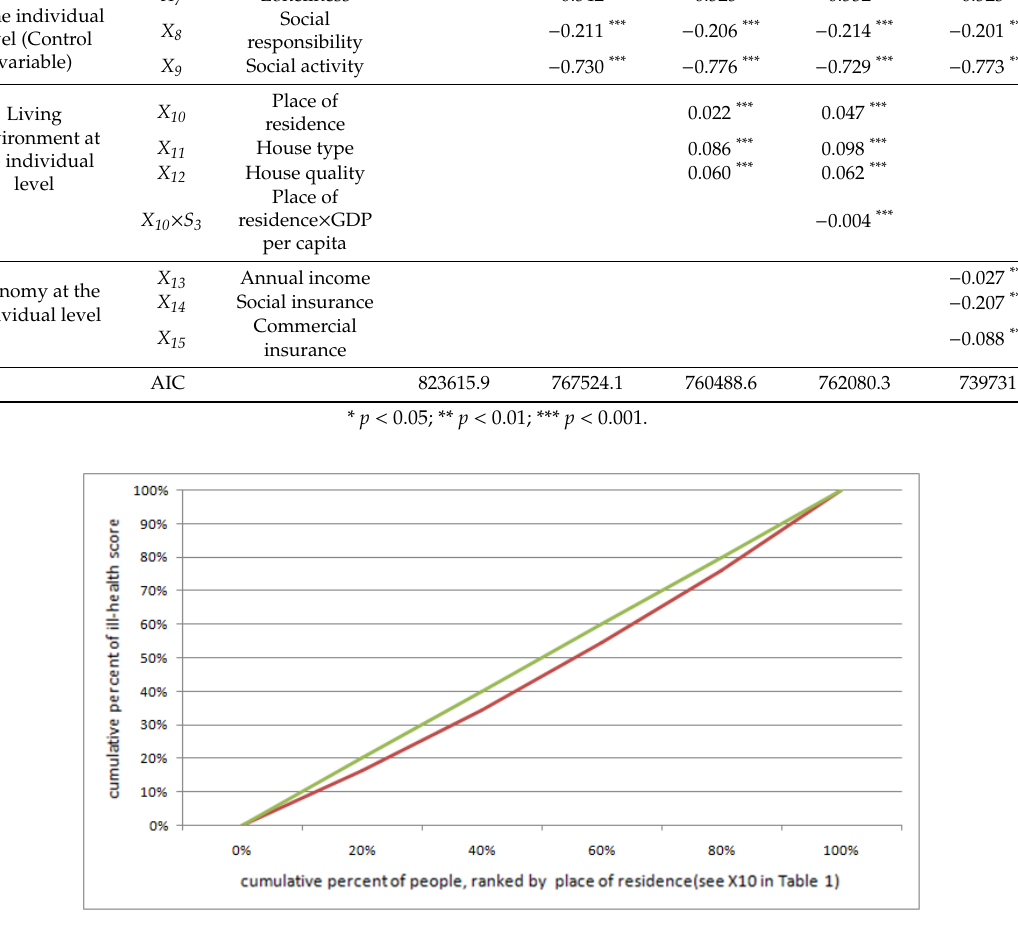
(b) Figure 5. Ill-health concentration curve (red curve) of elderly health by SES difference at the individual level in China. ( a ) Urban vs. rural-related elderly health inequality, CI = 0.3544; ( b ) income-related elderly health inequality, CI = − 0.1428. 4. Discussion 4.1.A Significant Geographical Differentiation in Elderly Health in China According to the 4th SSEP, the overall elderly health status in China shows a “high in coastal, poor in central” spatial pattern [26,46,49] with the higher health provinces being Tianjin, Jiangsu, Shanghai, Zhejiang, Fujian and Beijing. Combined with the studies discussed in Section 3.2 that analyze the determinants of health differences, we confirm that these six most affluent provinces have the best economic, medical and educational conditions. Based on the analysis of Local Moran’s I cluster, Figure 3 shows that the high-health group formed a health hot-spot region in the Yangtze River Delta. Comparing our results with the conclusions of Du (2013) on the health inequalities of the elderly before 2008 [37], we find that the higher health hot-spot region was shrinking, and Jilin, Liaoning, Beijing, Tianjin, Hebei, Shanxi, Shandong, Henan, Hubei and Anhui provinces no longer belonged to the health hot-spot region. This indicates that inter-provincial health equality is increasing from a geographical perspective. In contrast, Inner Mongolia and Gansu, which are places in which the SES in China is the worst, make up a poor health hot-spot region, indicating that this area and its neighboring provinces suffer the most serious health inequalities in China. 4.2. Elderly Health Inequality at the Provincial Level and Its Determinants